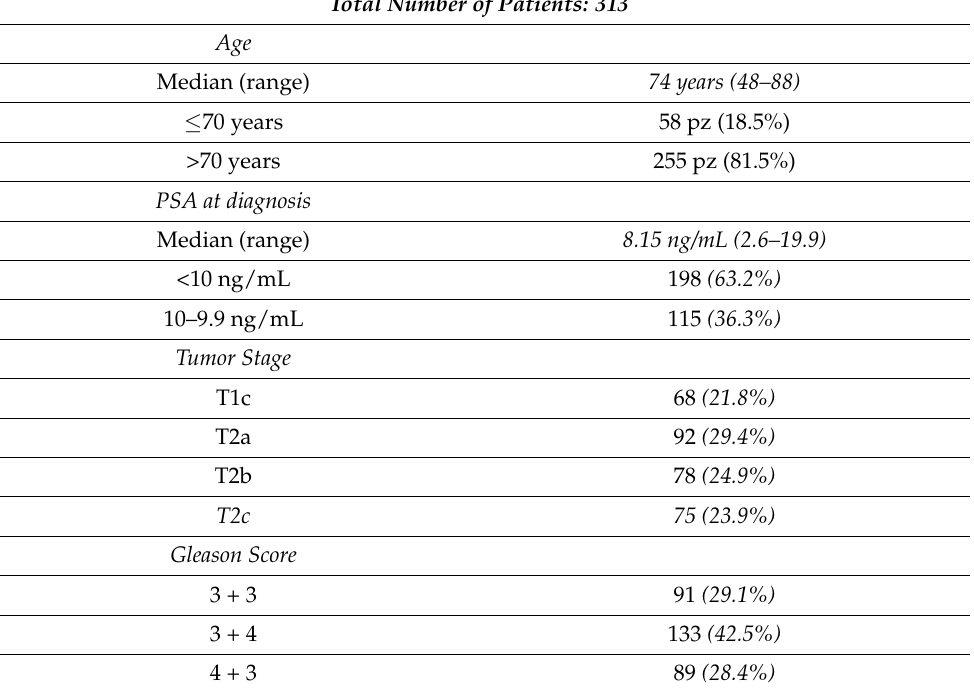
Table 1. Patients’